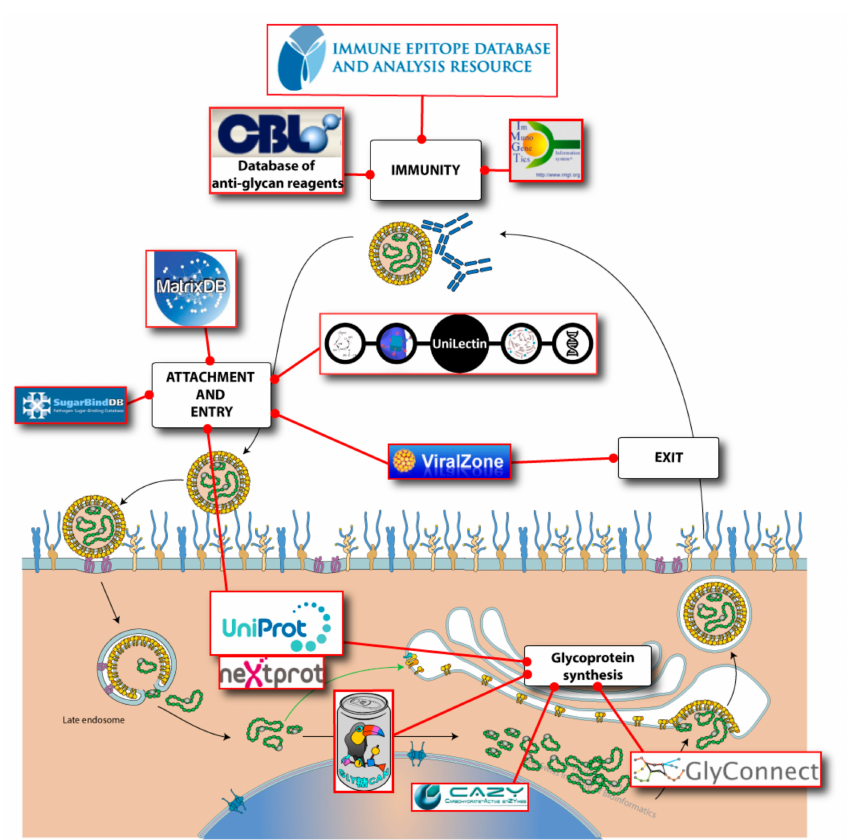
Figure 1. Virus interaction with glycans mapped with corresponding bioinformatics